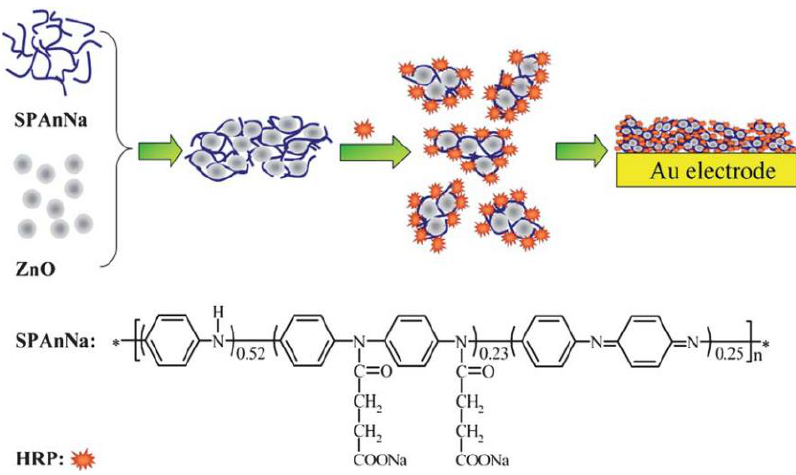
Figure 12. Schematic representations of preparation of an HRP − SPAnNa − ZnO / Au electrode. Republished with permission of the Royal Society of Chemistry from [116].